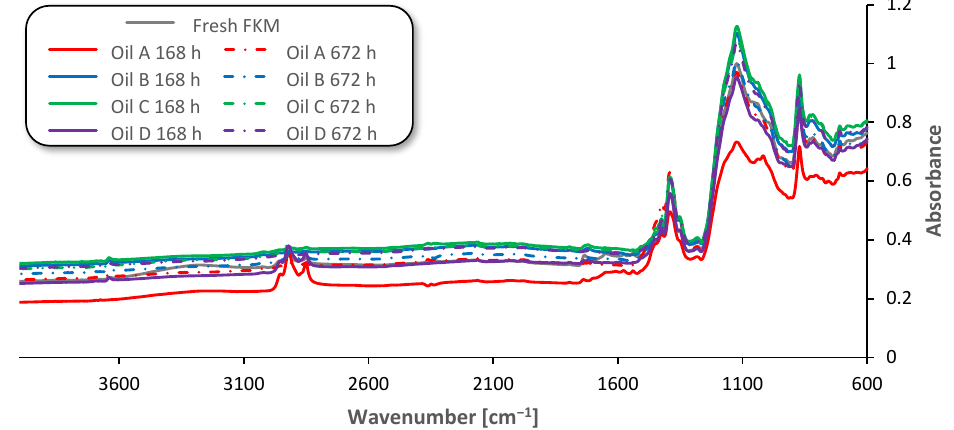
Figure 8. ATR-FTIR absorbance spectra (Beer’s Law) of the FKM samples.